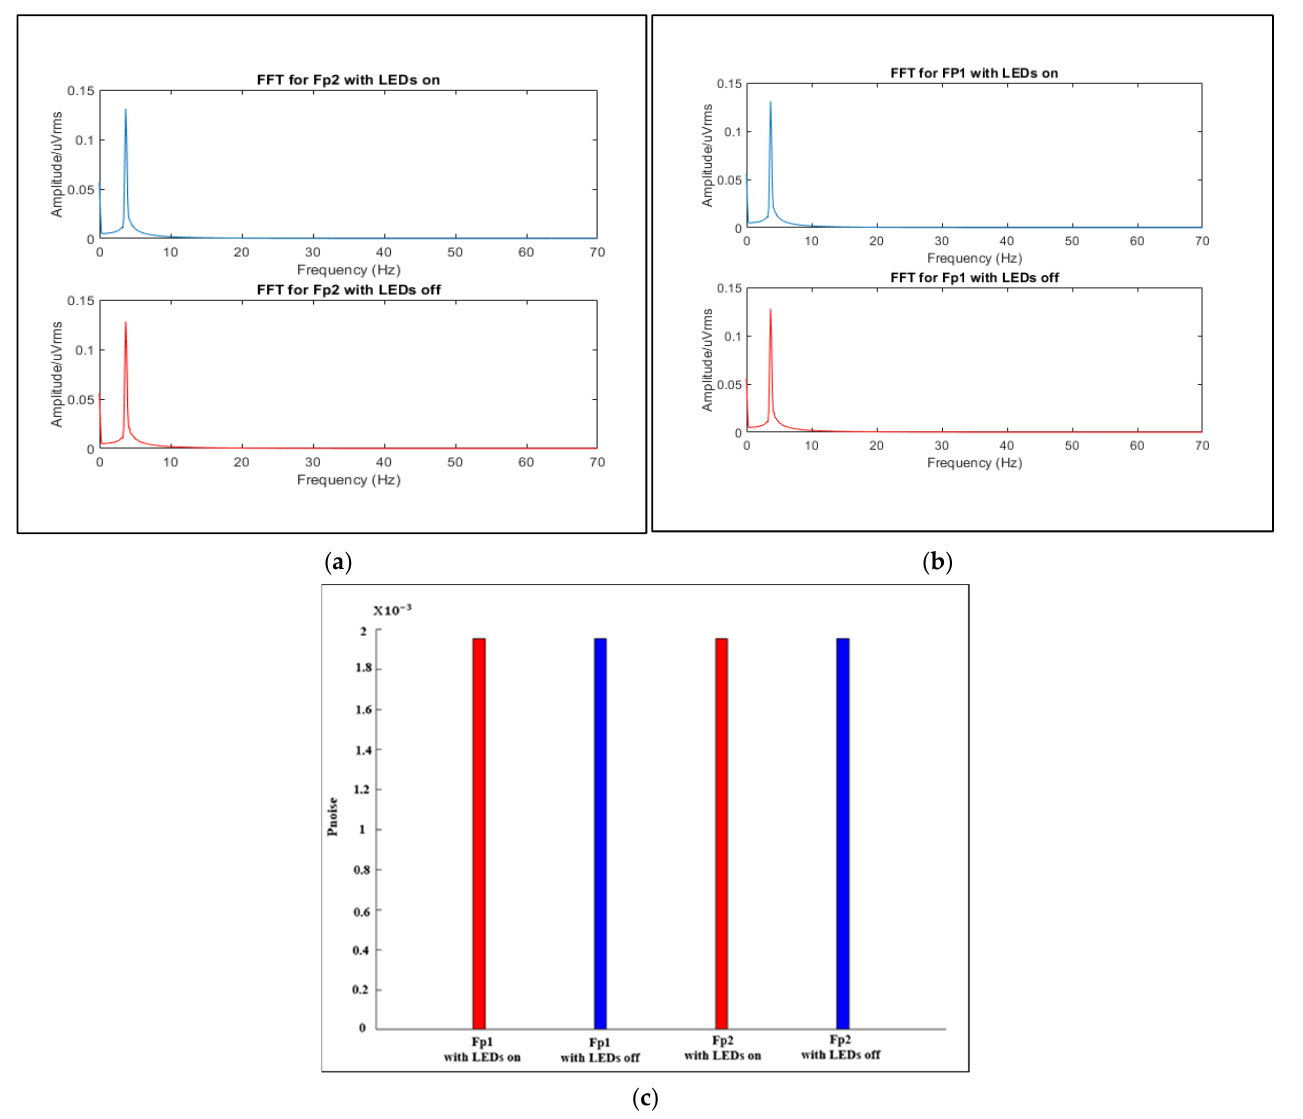
Figure 19. FFT spectra of signals measured at ( a ) Fp1 and ( b ) Fp2. ( c ) Sum of the extracted signal intensities at a 16 Hz fNIRS switching frequency.